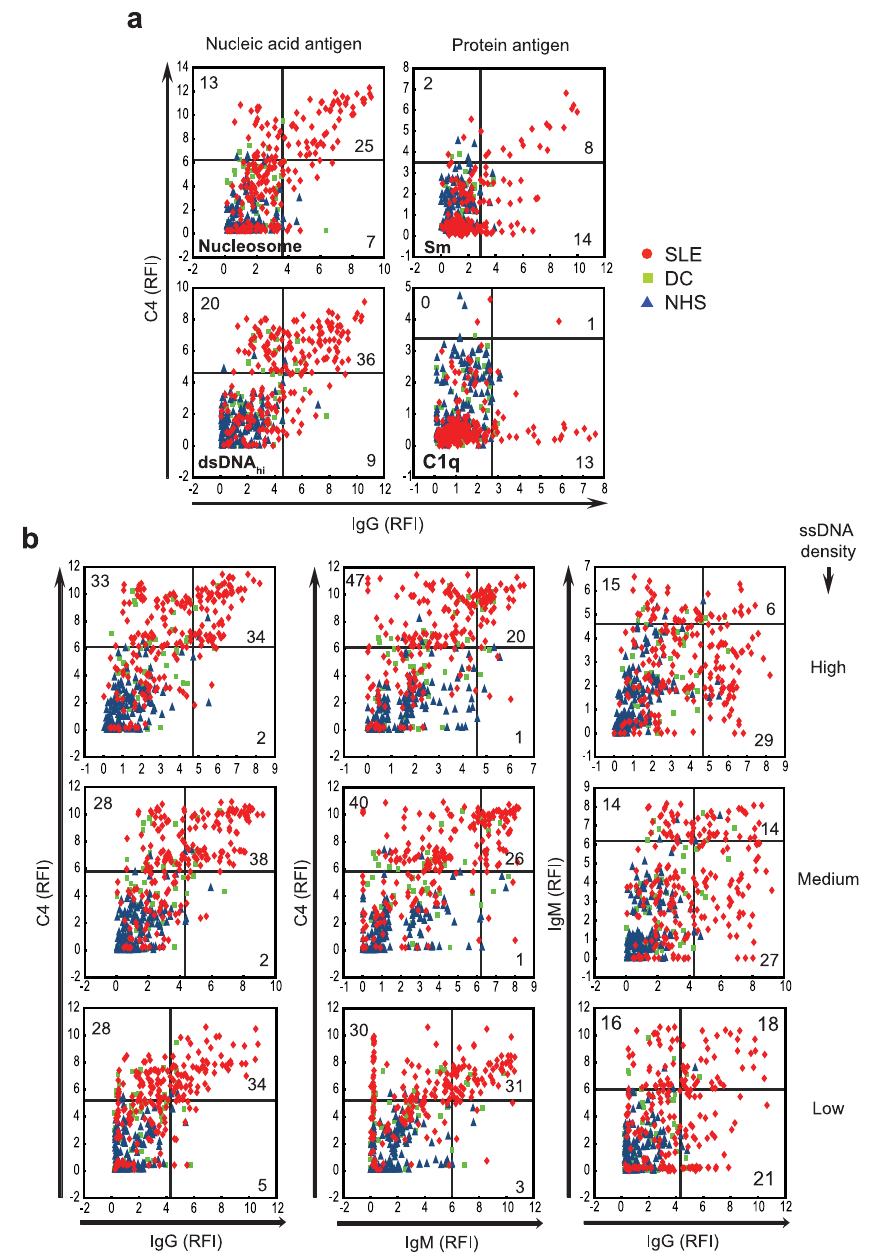
Fig 2. Antibody binding and complement C4 deposition on various antigens. Scatterplots show the relationship between IgG reactivity and C4 deposition in the sera of healthy (NHS), disease control (DC) and SLE subjects. Numbers indicate percentage of SLE subjects in the respective quadrants, which were generated by the 98th percentile boundaries of the NHS group. Antigens of different biochemical nature (a) and of different epitope density (b) are shown. ssDNA, single-stranded